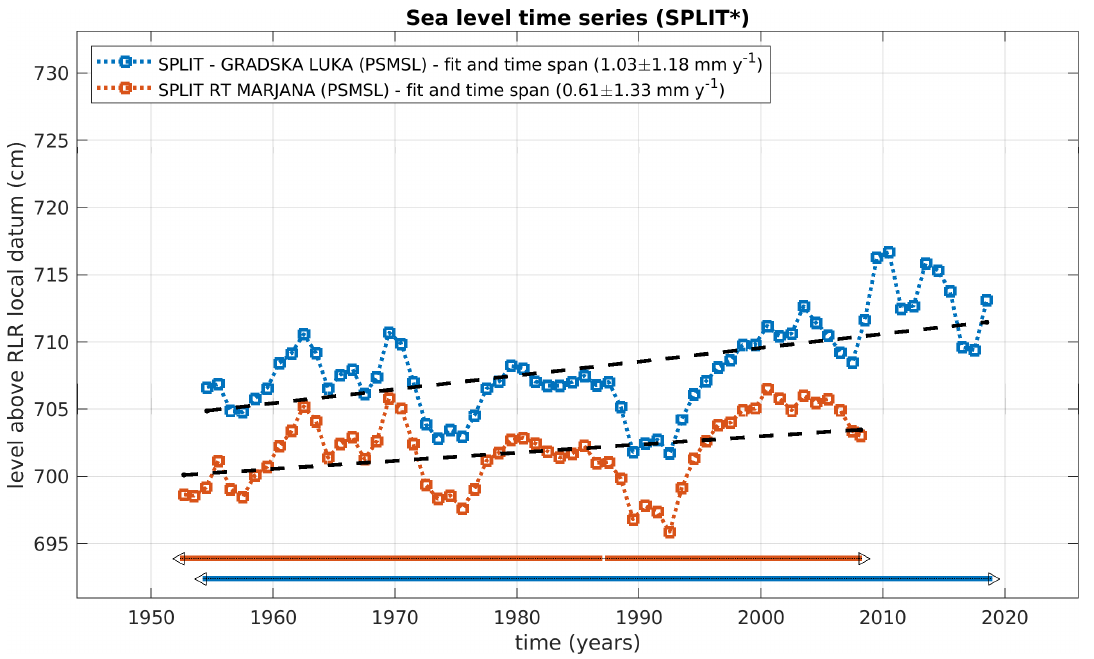
Figure 5. SL time series of SPLIT GRADSKA LUKA and SPLIT RT MARJANA downloaded from PSMSL. Time series were recorded by two TGs, one installed at Split harbor (SPLIT G.L.) and the other at Split promontory extending westward from the mainland into the Bay of Kaštela. Meanings of lines shown in plot are the same as in Figure